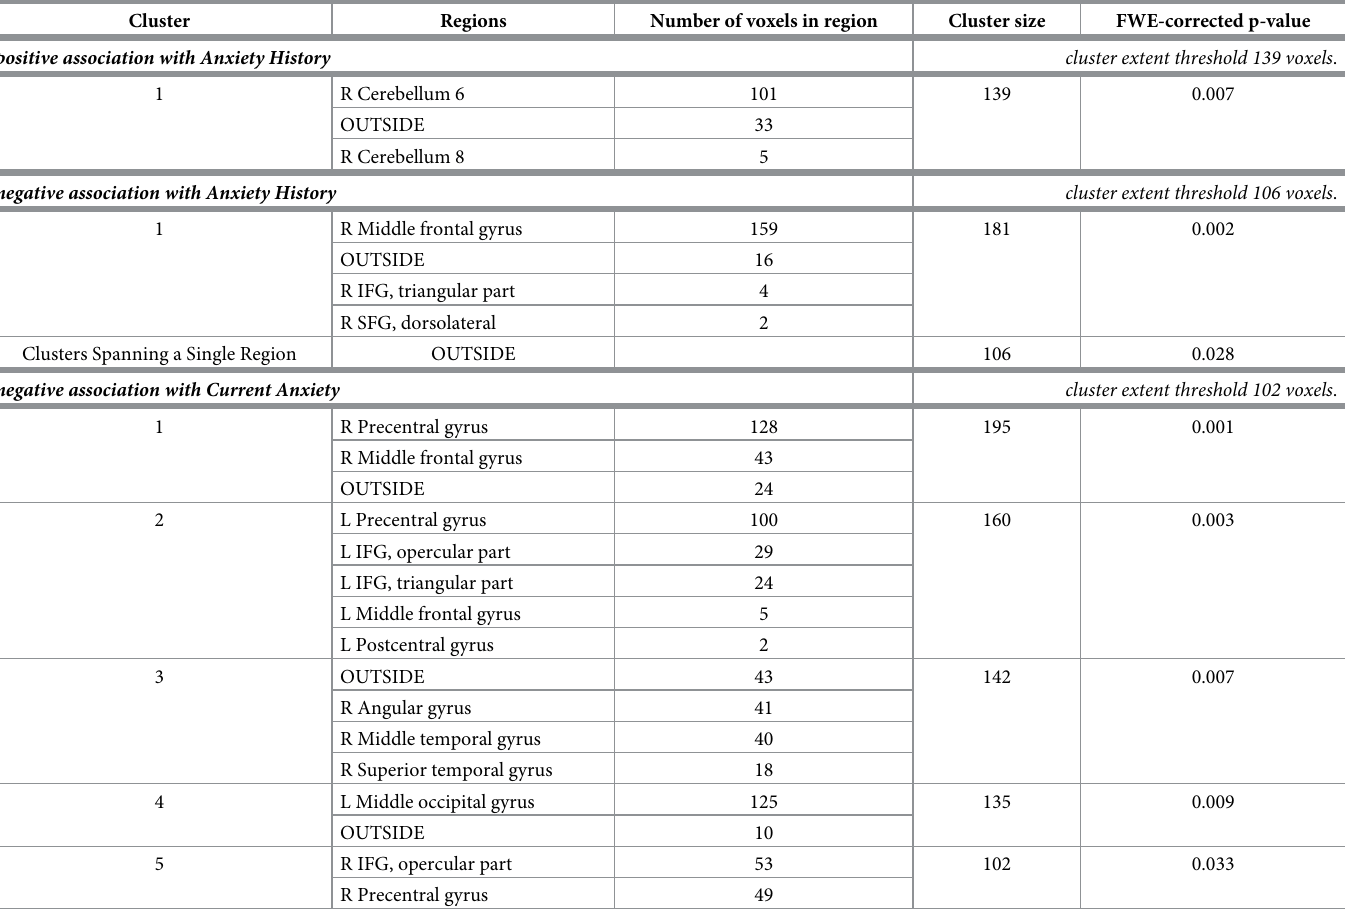
Table 6. Model of current and past anxiety disorders. Brain regions showing differences in maternal activation to own infant in positive versus negative emotion tasks (InfOwnPos > InfOwnNeg) related to current diagnosis or history of anxiety disorders.